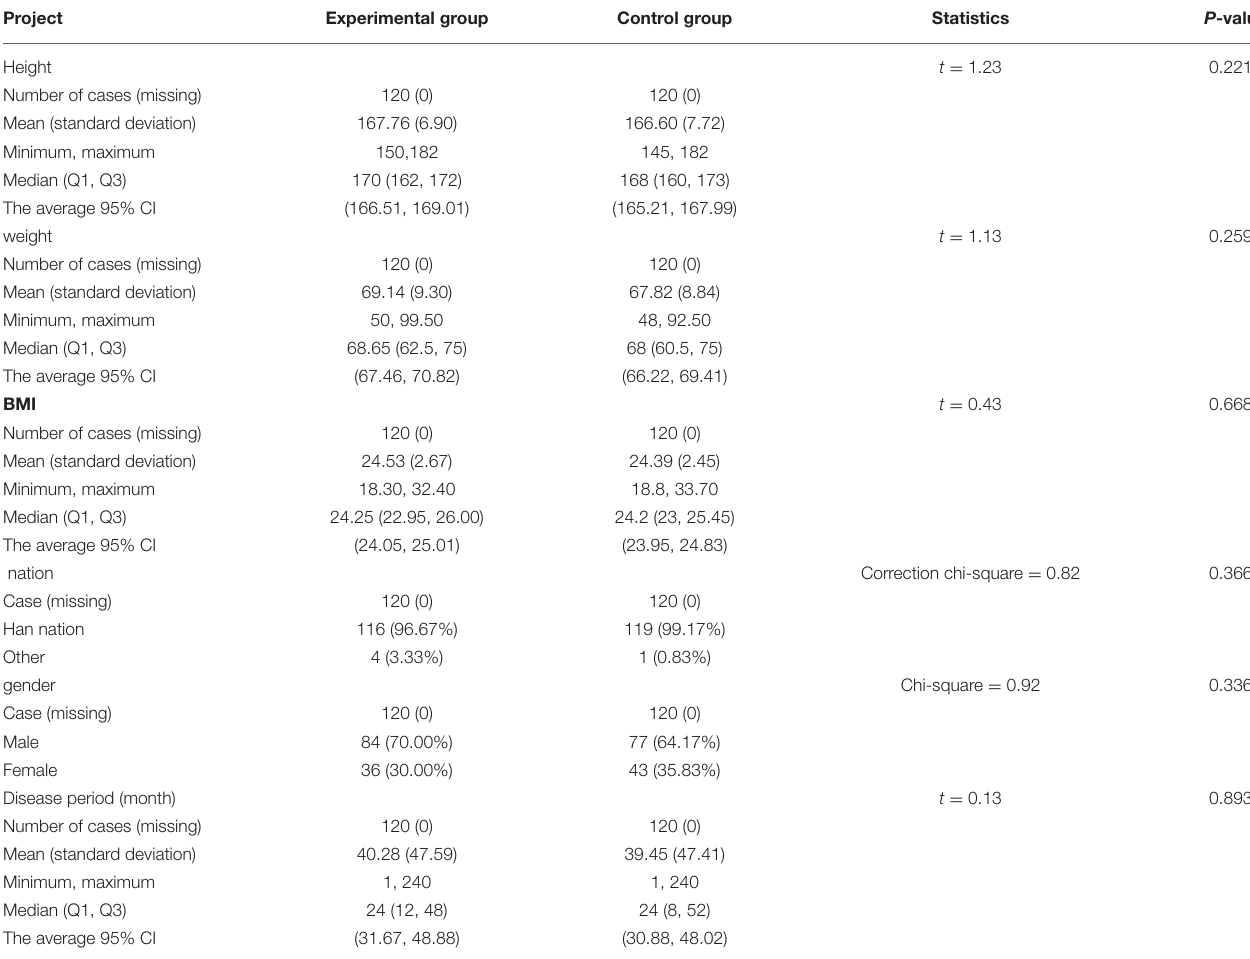
TABLE 4 | Baseline comparison of demographic data between the two